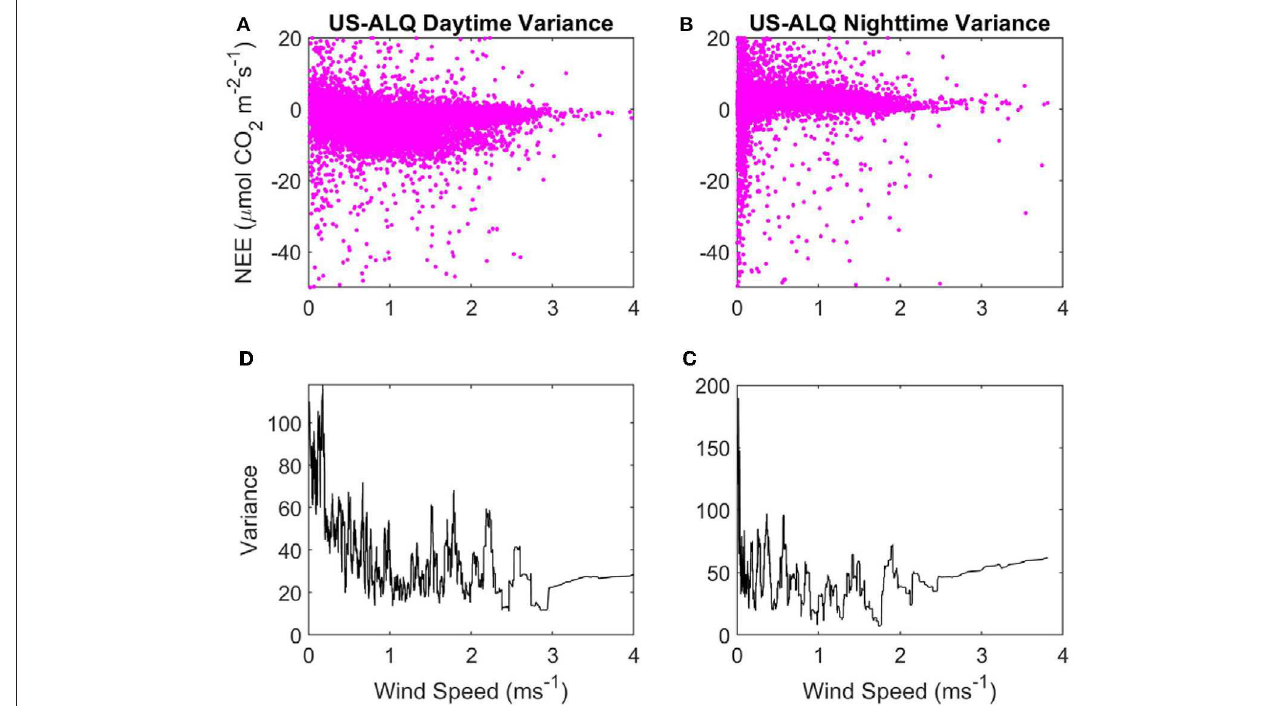
FIGURE 4 | Variance of NEE with WS at the sheltered fen US-ALQ: (A) Daytime NEE vs. WS. (B) Nighttime NEE vs. WS. (C) Variance of nighttime NEE vs. WS. (D) Variance of daytime NEE vs. WS. Pink, half-hourly NEE; black, variance of NEE.